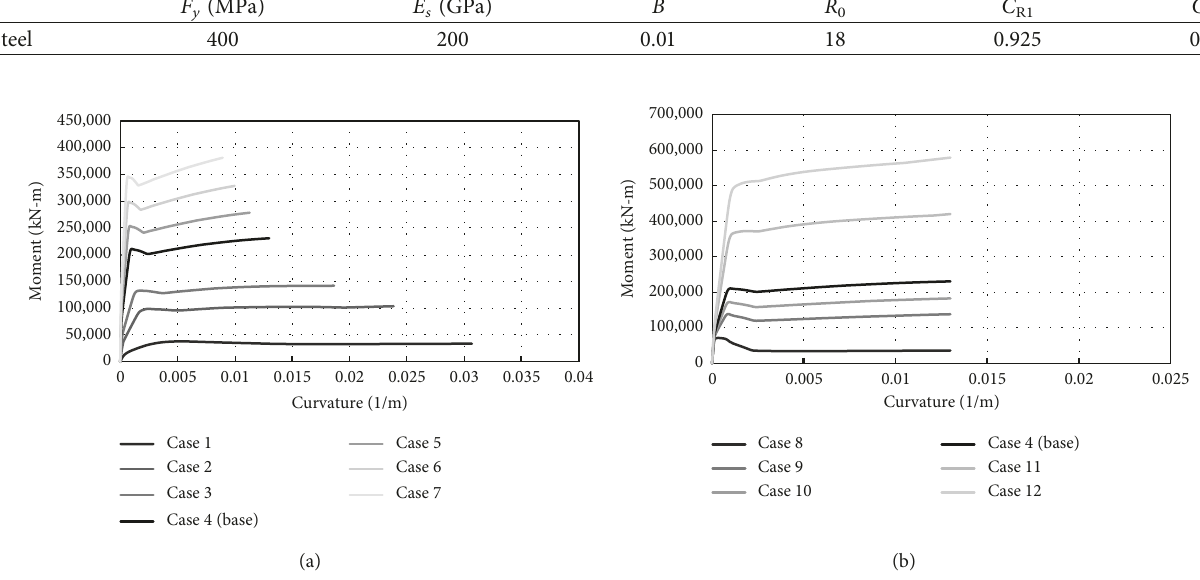
Figure 6: Moment-curvature relationship of the abutment along the longitudinal direction. (a) Variation in sectional area. (b) Variation in reinforcement